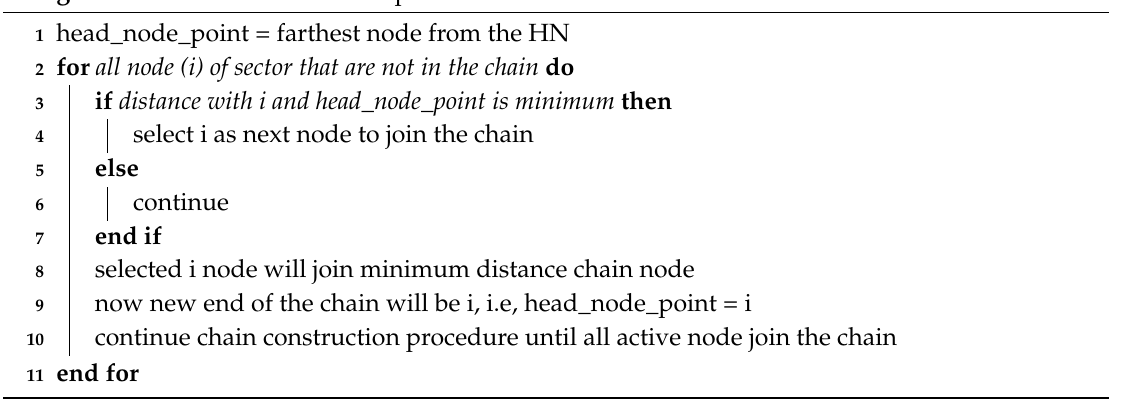
Algorithm 2: Chain construction procedure for each sector